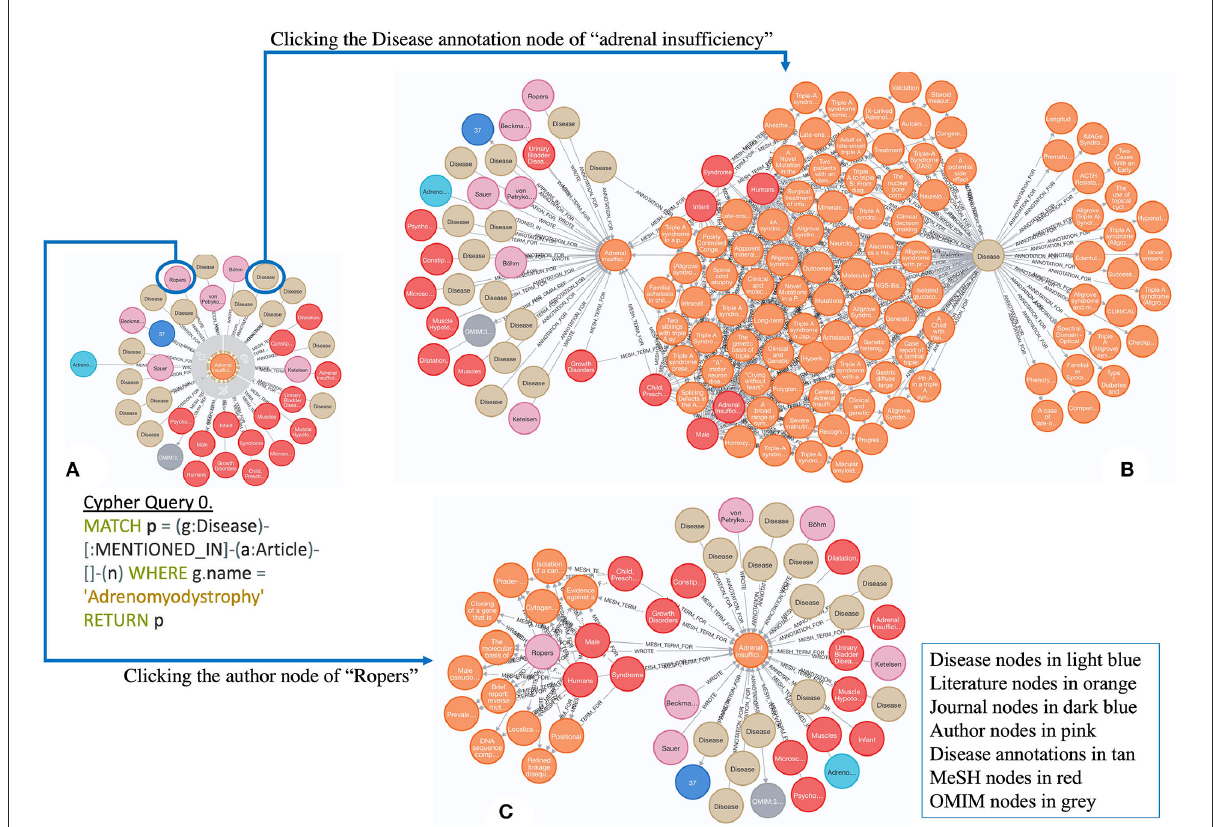
FIGURE1 An example of exploring Adrenomyodystrophy-associated literature [ A : a graph containing semantic annotations generated from the original paper for Adrenomyodystrophy; B : an expanded graph from A via one disease node of “adrenal insufficiency”; C : an expanded graph from A via one author node of “Ropers.” The attached Cypher Query 0 was applied to generate A . (B,C) can be generated by clicking the nodes circled in A , respectively].